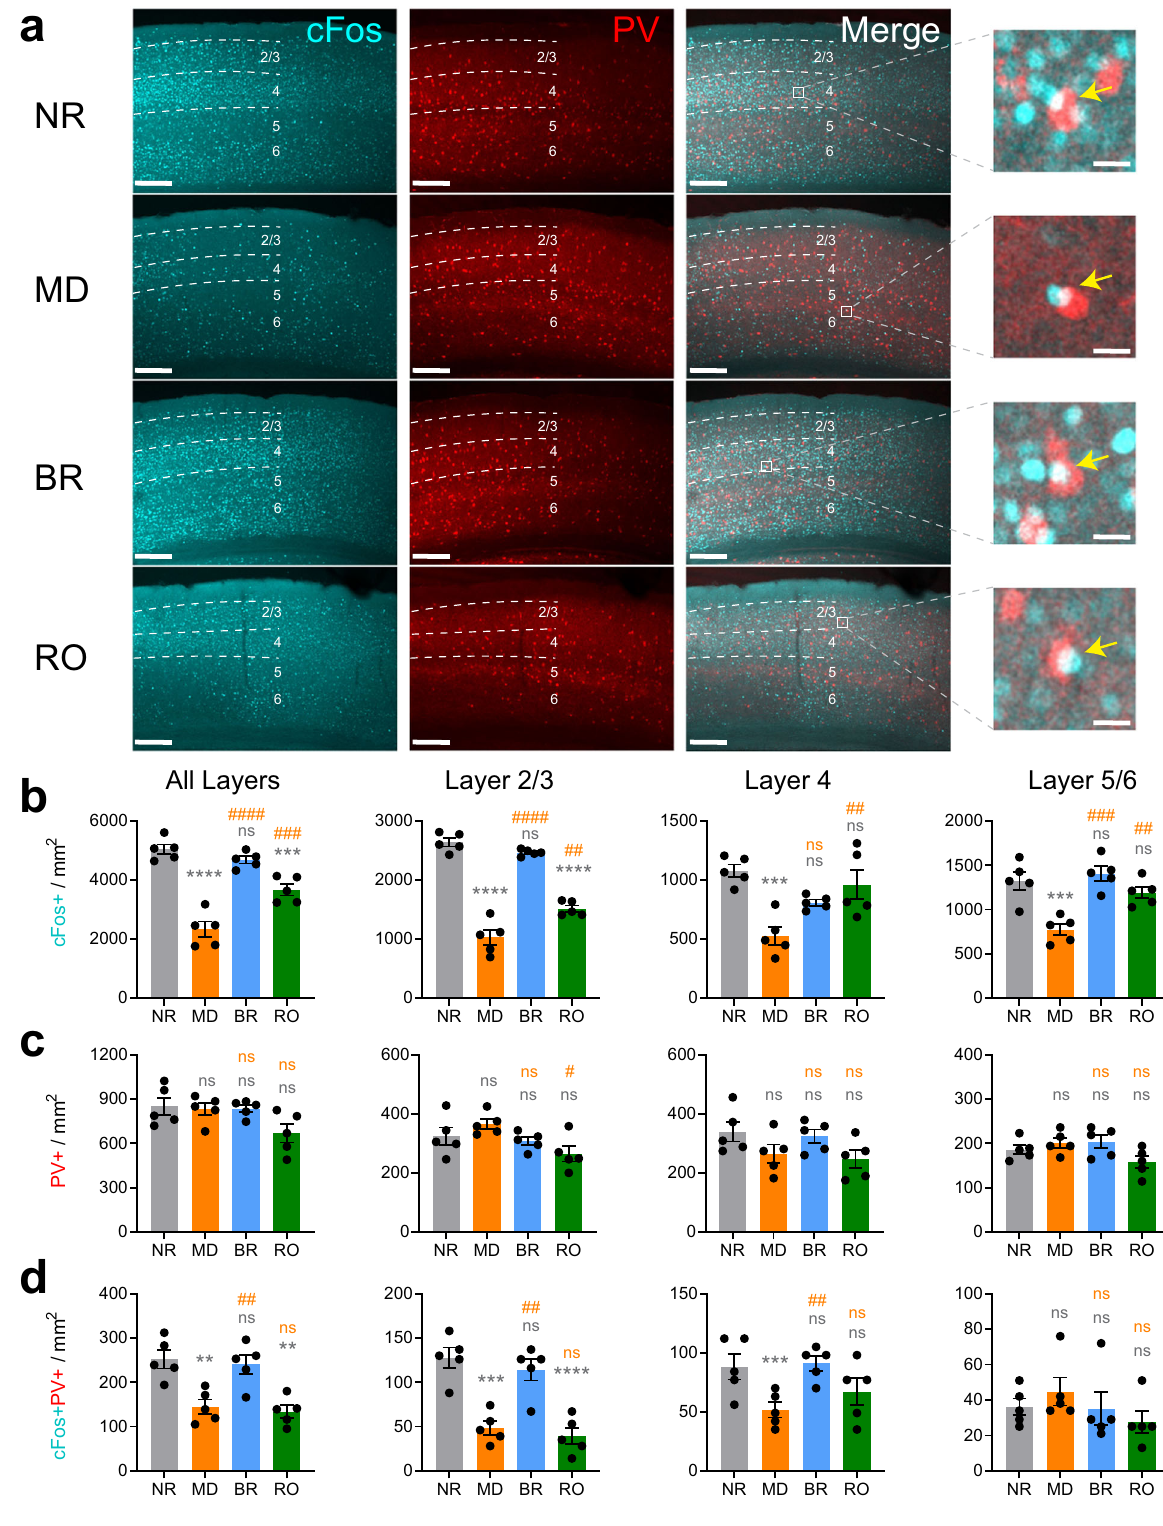
acuity. Finally, and consistent with prior work in cats 20 5-day RO led to signi fi cantly reduced visual acuity in both eyes. Taken together, these data suggest that differential response properties in V1 for BR vs. RO mice are associated with subtly different outcomes for visual acuity, with BR mice showing less disruption of vision than RO